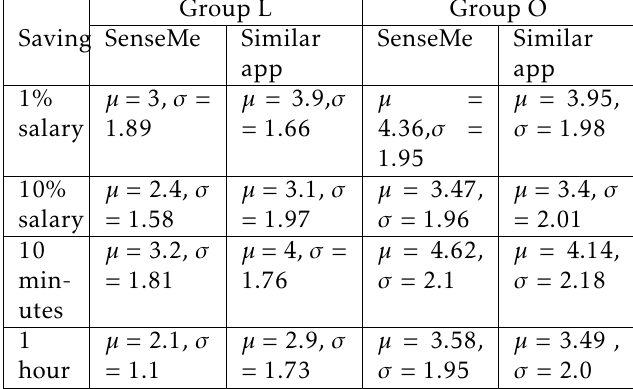
Table 3. Relationship between participants’ group and